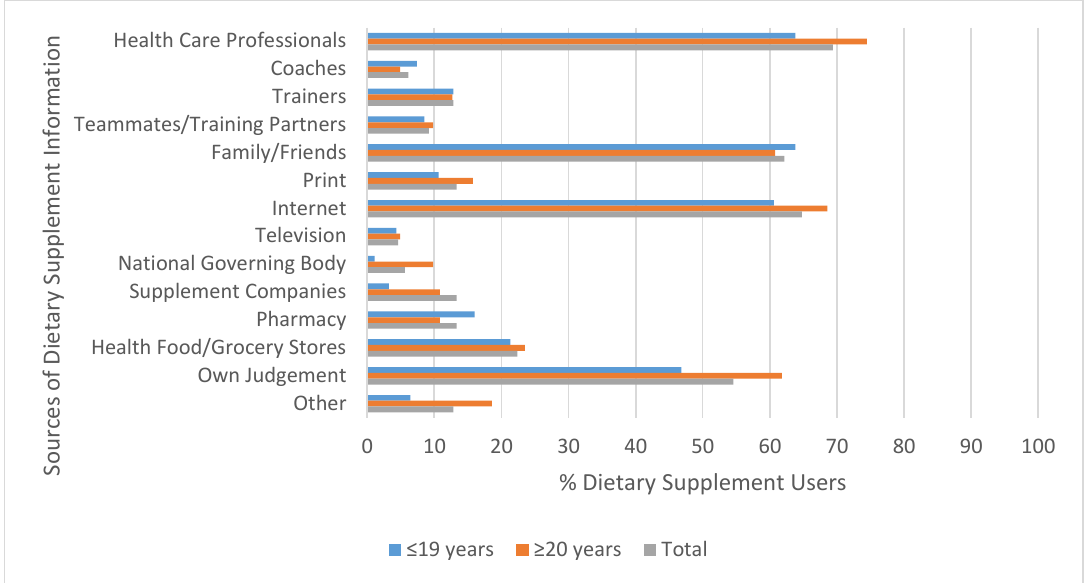
Figure 2. Percentage (%) of supplement users referring to sources of dietary supplement information based on age ( n = 94 for ≤19 years; n = 102 for ≥20 years; n = 196 for total).